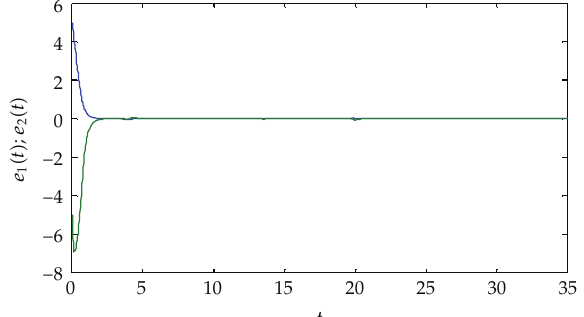
Figure 4: Synchronization errors of systems (cid:2) 3.1 (cid:3) – (cid:2) 3.7 (cid:3) with β (cid:9)